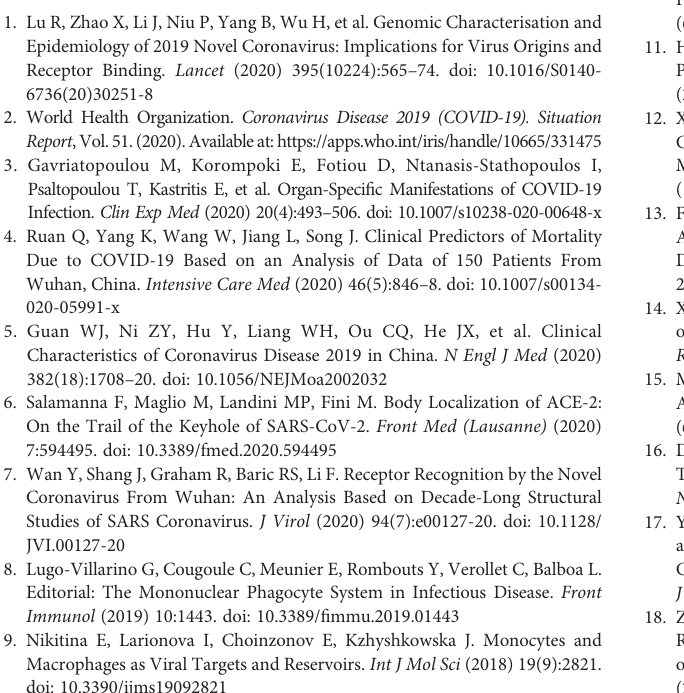
Supplementary Figure 1 | Representative histograms of ACE2, CD14, and CD16 in human monocyte-macrophages. Expression of SARS-CoV-2 cell entry